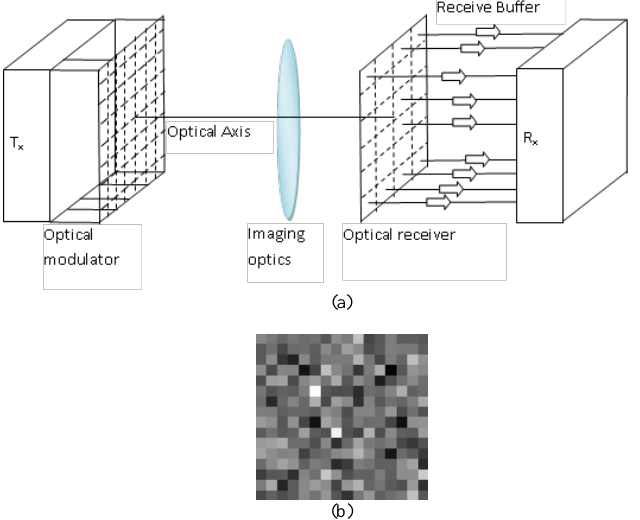
Figure 1. Illustration of ( a ) a pixelated optical wireless communication system [38] ( b ) a transmitted pixelated image.